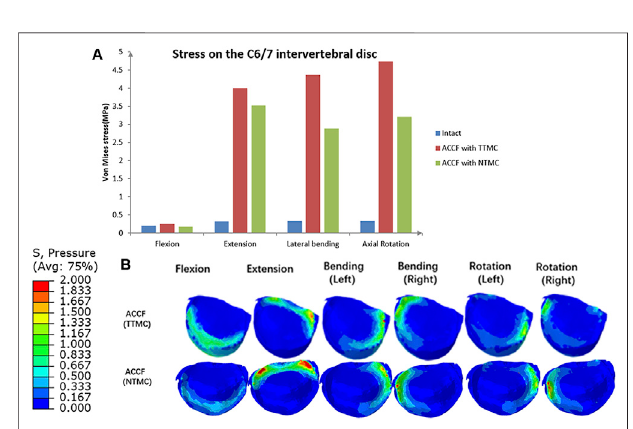
FIGURE 11 | (A) Comparisons of the maximum von Mises stresses in the IDP of the C6/7 segment among the intact model, TTMC model, and NTMC model; (B) Stress cloud map of IDP of the C6/7 segment between TTMC and NTMC